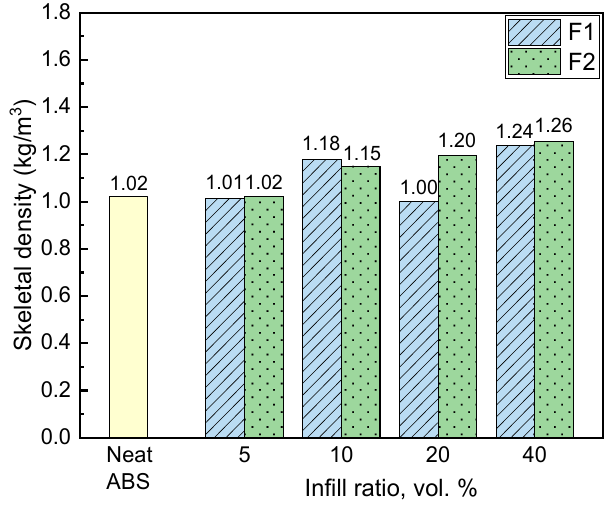
Figure 5. Skeletal density of neat ABS and composite samples.